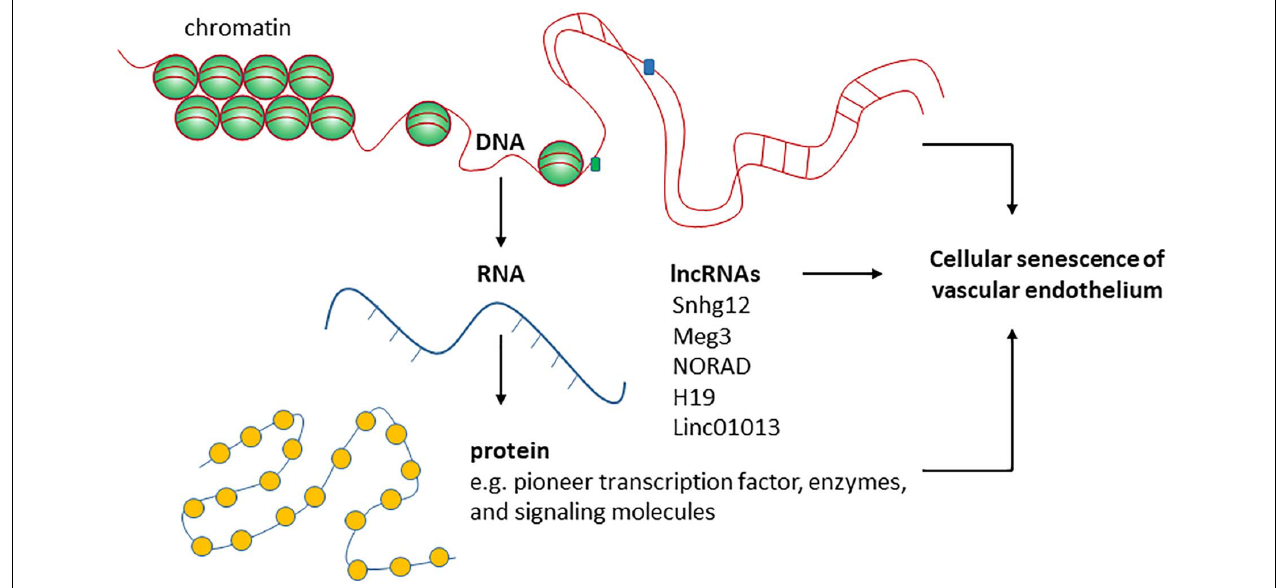
FIGURE 2 | The roles of functional RNA molecules in regulating endothelial cellular senescence are not well-